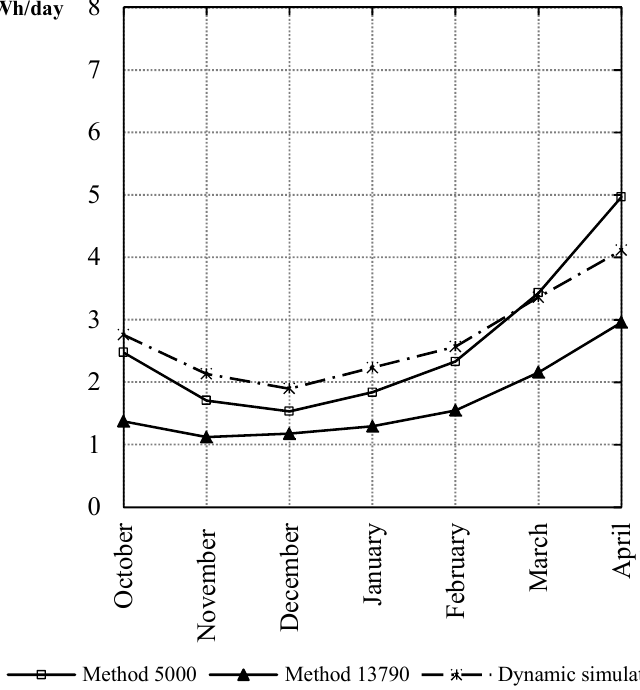
Figure 3. Influence of the sunspace evaluated according to the three methodologies during the heating period (global heat transfer coefficient of the partition wall 9.89